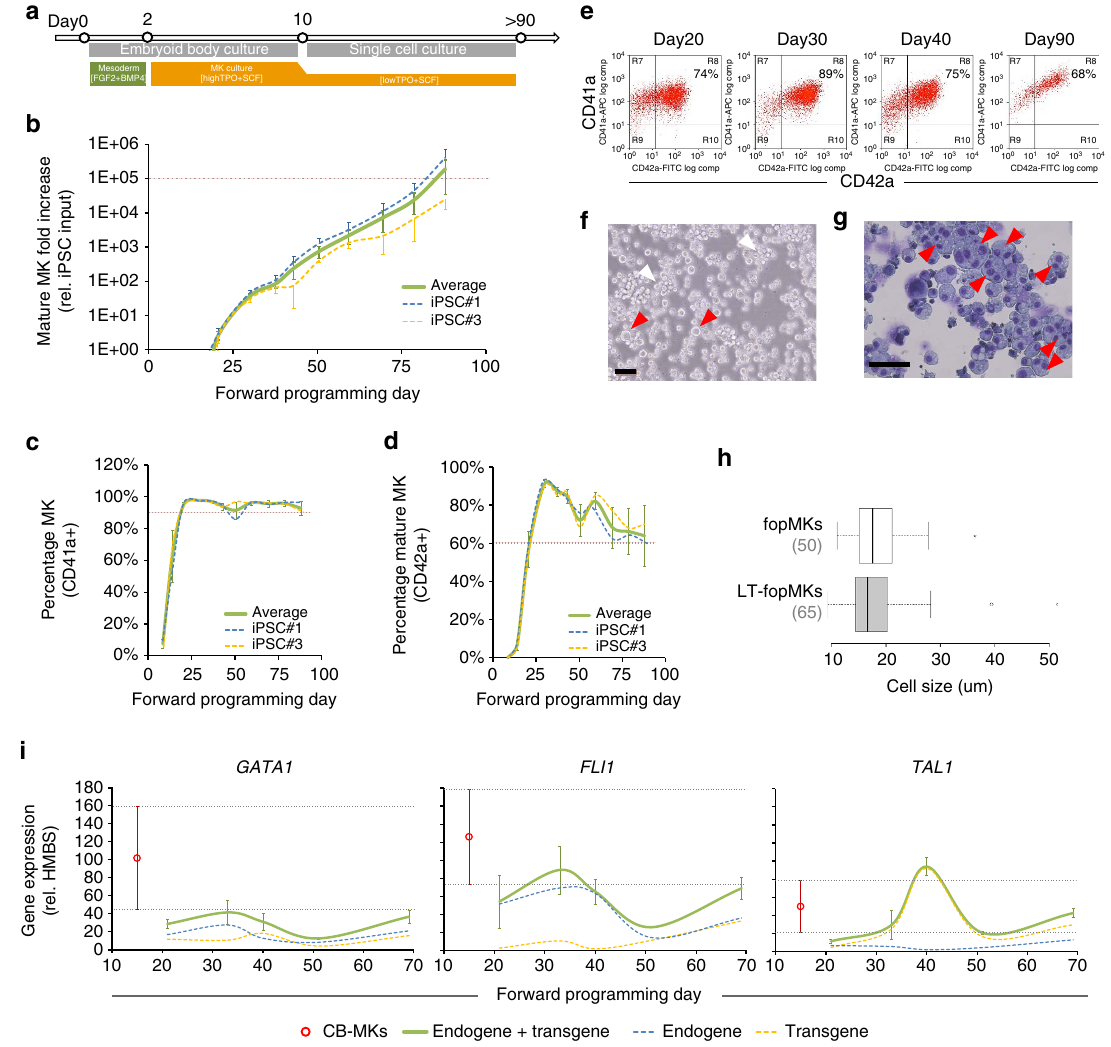
Figure 3 | Long-term expansion of fopMKs. ( a ) Schematic representation of the culture conditions for long-term MK-FOP. The combination of TPO (20ngml (cid:3) 1 ) and SCF (50ngml (cid:3) 1 ) allowed mature MK expansion for 90 days and beyond. ( b ) The cumulative mature MK (CD41a/CD42a double positive cells) fold increase relative to day 0 hiPSC cell input is shown for the hiPSC lines #1 ( n ¼ 4) and #3 ( n ¼ 5) over 90 days in culture (mean ± s.e.m.). ( c , d ) The corresponding percentages of CD41a þ and CD42a þ cells monitored by flow cytometry from whole cultures are shown over the 90 day period (mean ± s.e.m.). ( e ) Representative flow cytometry dot plots for CD41a and CD42a expression from the hiPSC#3 line. ( f , g ) Representative phase contrast picture of a day 70 hiPSC#3 fopMK long-term culture and associated Romanowsky staining of fixed cells (scale bars 50 m m). White arrowheads: clumps of actively growing small cells; red arrowheads: single big cells in suspension culture and polyploid cells identified by Romanowsky staining. ( h ) Cell size distribution from fopMK and LT-fopMK cultures is shown as box plots ( n ¼ 50, 65 respectively). ( i ) Endogenous and transgenic expression levels of the 3- TFs were independently monitored by RT-qPCR throughout MK-FOP long-term cultures (mean ± s.e.m. from hiPSC lines #1 and #3; n ¼ 3). The average range of expression levels in cbMKs (mean ± s.e.m.; n ¼ 5) is shown as a benchmark (in red).